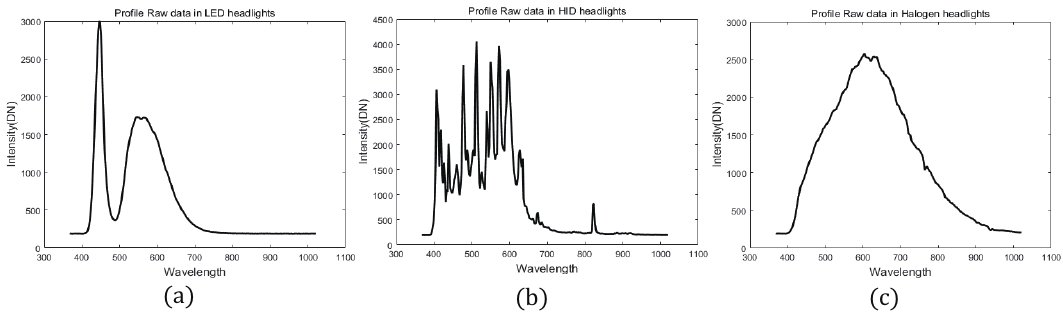
Figure 3. Measured spectral profiles of headlights ( a ) LED, ( b ) HID and ( c ) Halogen.